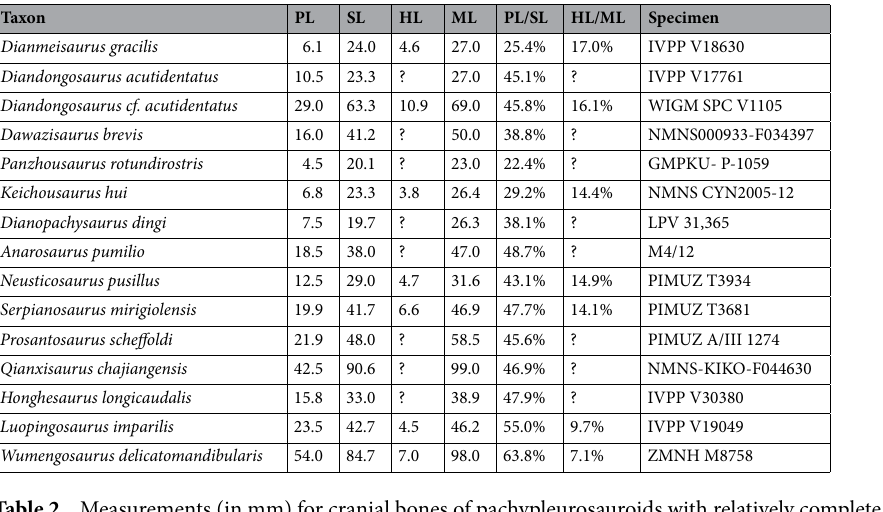
saurus the longest snout among this clade (PS = 63.8%). Analogous to crocodylians 43 , the divergence between short-snouted (brevirostrine) keichousaurids and relatively long-snouted (longirostrine) pachypleurosaurids was probably driven by ecological specializations related to feeding and foraging. Pachypleurosauroids generally have a flattened skull with the tooth row restricted to a level in front of the orbit, and the peg-like teeth seem to be designed for grasping prey with a quick sweeping bite 44 . The snout elongation apparently increases the length of the tooth row, which could be more effective for grasping prey and preventing prey from escaping. Additionally, the longer snouts in derived pachypleurosauroids have a more pointed anterior tip than those in basal forms, and they might have evolutionary advantage in chasing fast swimming preys because the pointed tip helps direct the flow of water over the body surface to reduce drag. Outside of pachypleurosauroids, a similarly anteriorly pointed snout associated with an elongate trunk is otherwise present in some thalattosaurs 45 , and this likely represents convergent adaptation driven by similar feeding and swimming mechanics. The discovery of Luopingosaurus provides new information on the hyobranchial apparatus and feeding adap- tion in pachypleurosauroids. The superb preservation of the holotype shows that Luopingosaurus has a pair of rod-like hyoids, which may have played an important role in securing prey because rapid depression and retrac- tion of the hyobranchial apparatus following sudden opening of jaws would have created the suction necessary to draw the prey into the buccal cavity. Besides Luopingosaurus , well-developed hyoids are also known in some other pachypleurosauroids 8–12,18,22 , although they are unknown in the remaining members of this clade prob- ably because of incomplete preservation. Based on this feature, Rieppel 44 proposed that pachypleurosauroids likely employed suction as a primary solution to the biomechanical problems associated with feeding in a liquid medium, resembling cetaceans and many other aquatic vertebrates 46 . To trace the variation of hyoid bones in ratios (17.0% in Dianmeisaurus and 16.1% in Diandongosaurus ), keichousaurids and European pachypleurosau- rids have moderate ratios of 14.1–14.9%, and Chinese pachypleurosaurids the lowest ratios of 7.1–9.7% (Table 2).